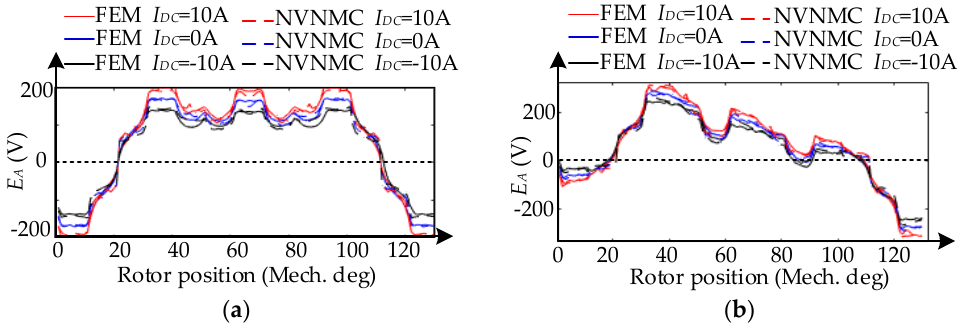
Figure 11. Back-EMF of phase A with different DC currents: ( a ) No phase current; ( b ) Feeding 3 phase AC current with the peak of 3 A.